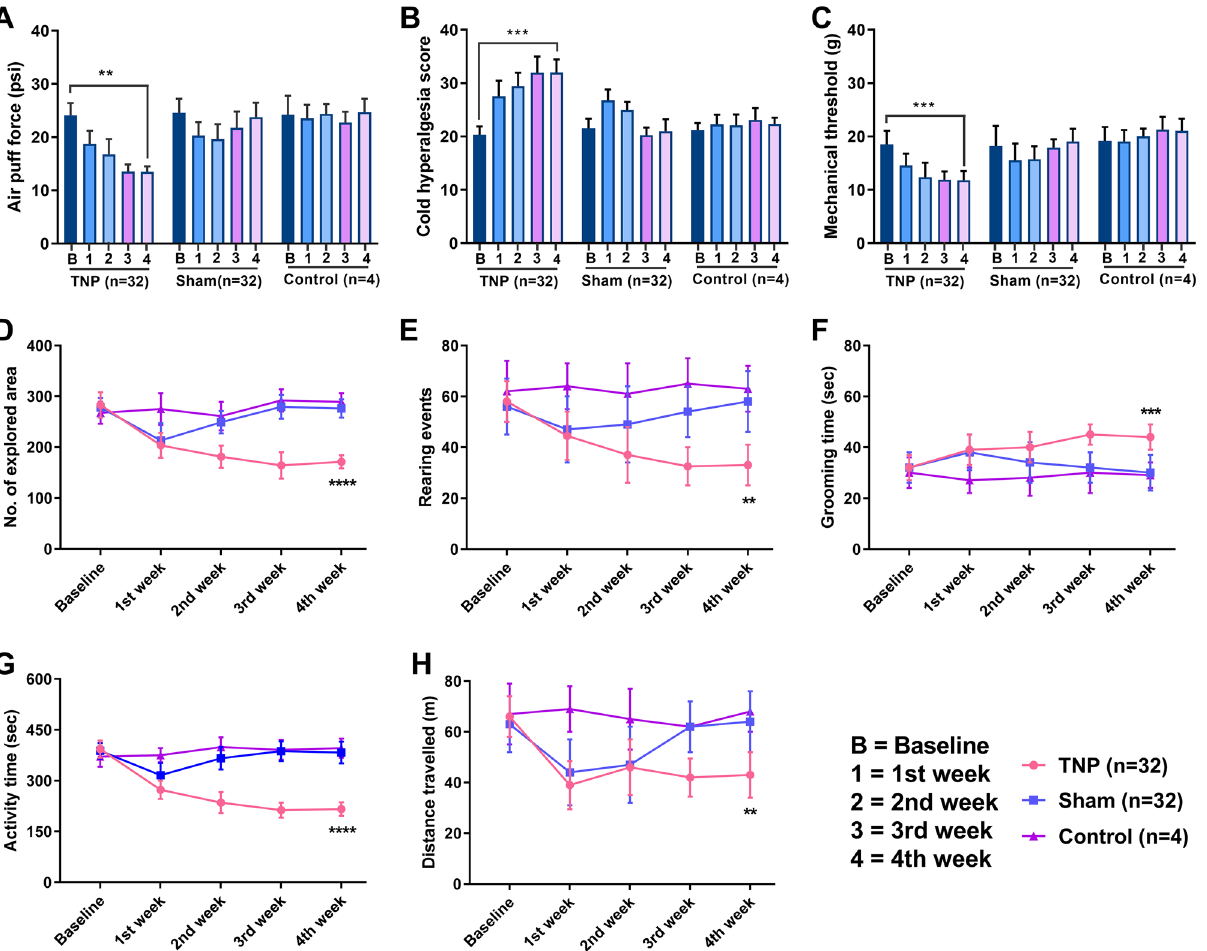
Figure 2. Trigeminal pain behavioral scores after CCI-ION surgery. ( A ) Results from the air-puff test on the ipsilateral trigeminal facial area. ( B ) Cold allodynia score results for the ipsilateral facial area with acetone drops. ( C ) Mechanical allodynia (von Frey test) results for the ipsilateral facial area. ( D – H ) Results of the open field test: ( D ) number of explored areas, ( E ) number of rearing events, ( F ) duration of grooming time, ( G ) duration of active time, and ( H ) distance traveled. **, p < 0.01; ***, p < 0.001; ****, p < 0.0001, repeated measures one-way ANOVA. Data are displayed as means ±